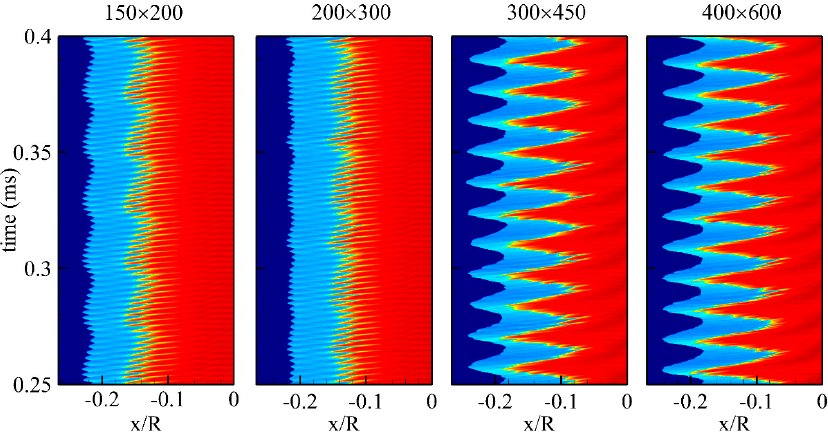
Figure 14. Streamline extraction of the temperature contour for the Jachimowski - 92 mechanism at various grid levels. Color scale is the same as Figure 9.